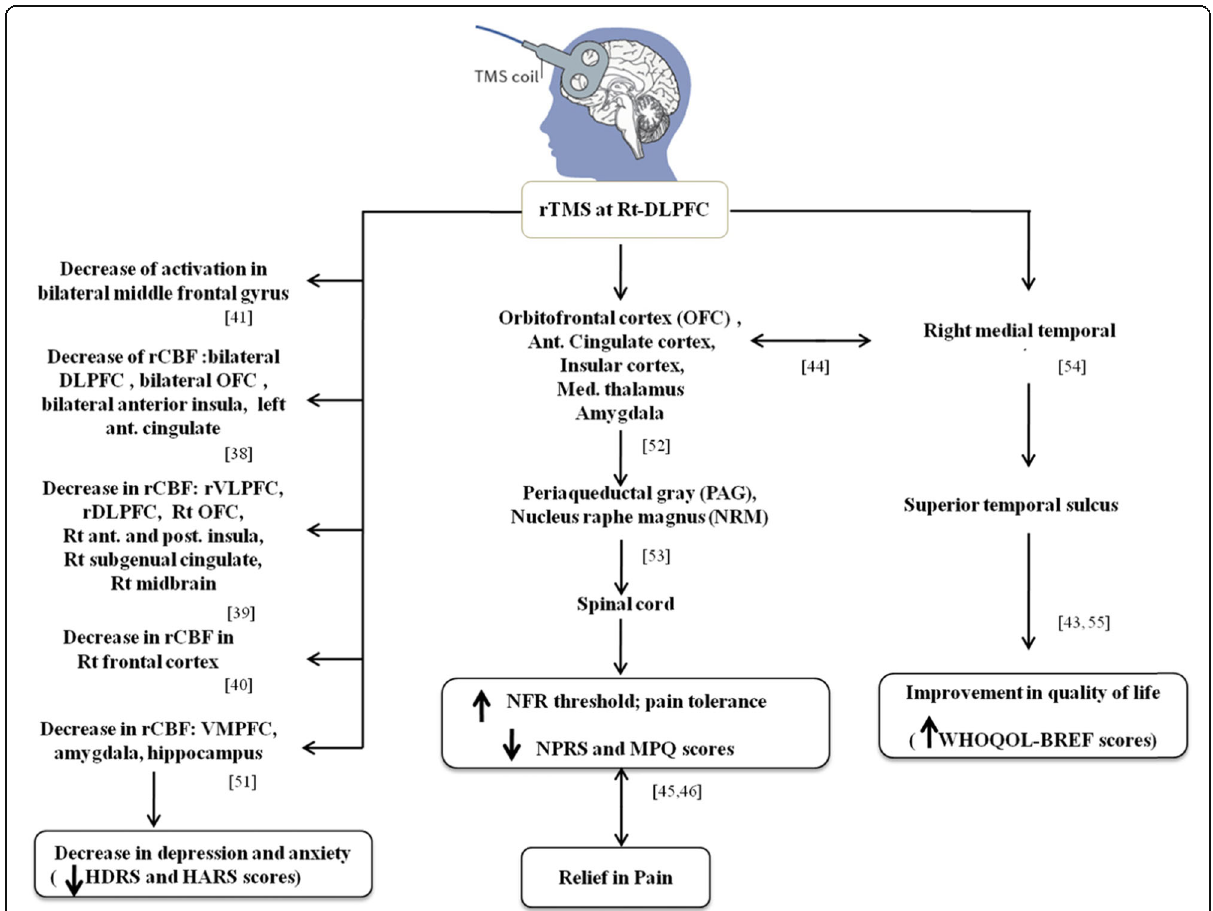
Fig. 5 : Putative mechanism for the effect of low frequency right DLPFC in fibromyalgia syndrome. Proposed mechanism for effect of Rt DLPFC rTMS on pain and related symptoms of FMS. (rDLPFC = right dorsolateral prefrontal cortex; rVMPFC = right ventromedial prefrontal cortex; ACC = anterior cingulate cortex; OFC = orbitofrontal cortex; rCBF = regional cerebral blood flow). ‘ Skull with TMS coil ’ image was adapted from Diana et al.,